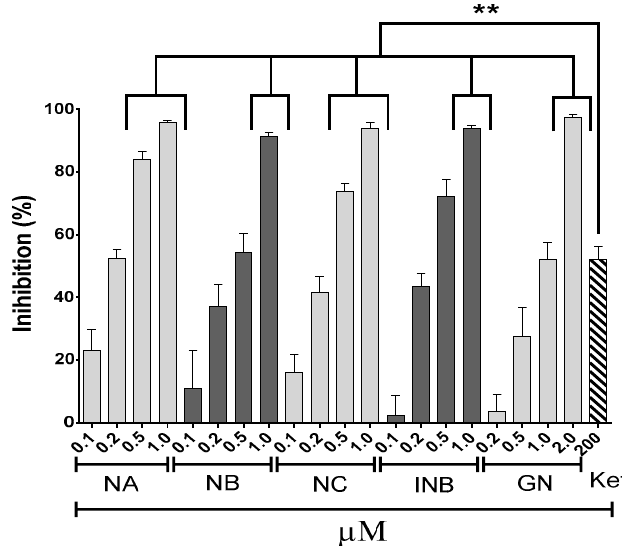
Figure 1 . Inhibitory effects of Okinawa propolis (OP) compounds on albumin denaturation in vitro. Ketorolac (Ket) was used as a control, and asterisks indicate significant differences compared to the positive control (** p < 0.01).